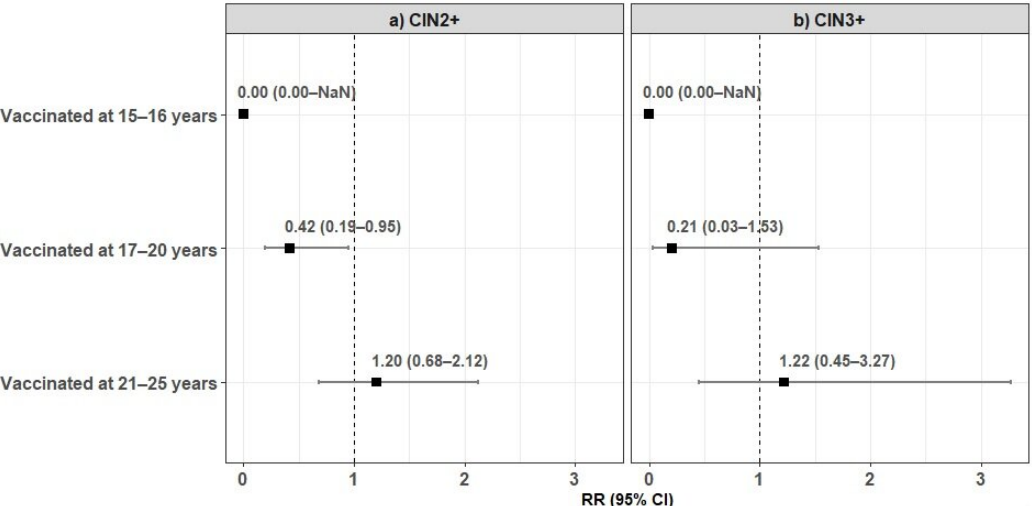
Figure 2. Forest plot of the relative risks of CIN2+ ( a ) and CIN3+ ( b ) in vaccinated vs. unvaccinated women, according to age at vaccination, with 95% confidence intervals. Note: RR: Relative Risk; 95% CI: 95% Confidence Interval; NaN: Not a number.